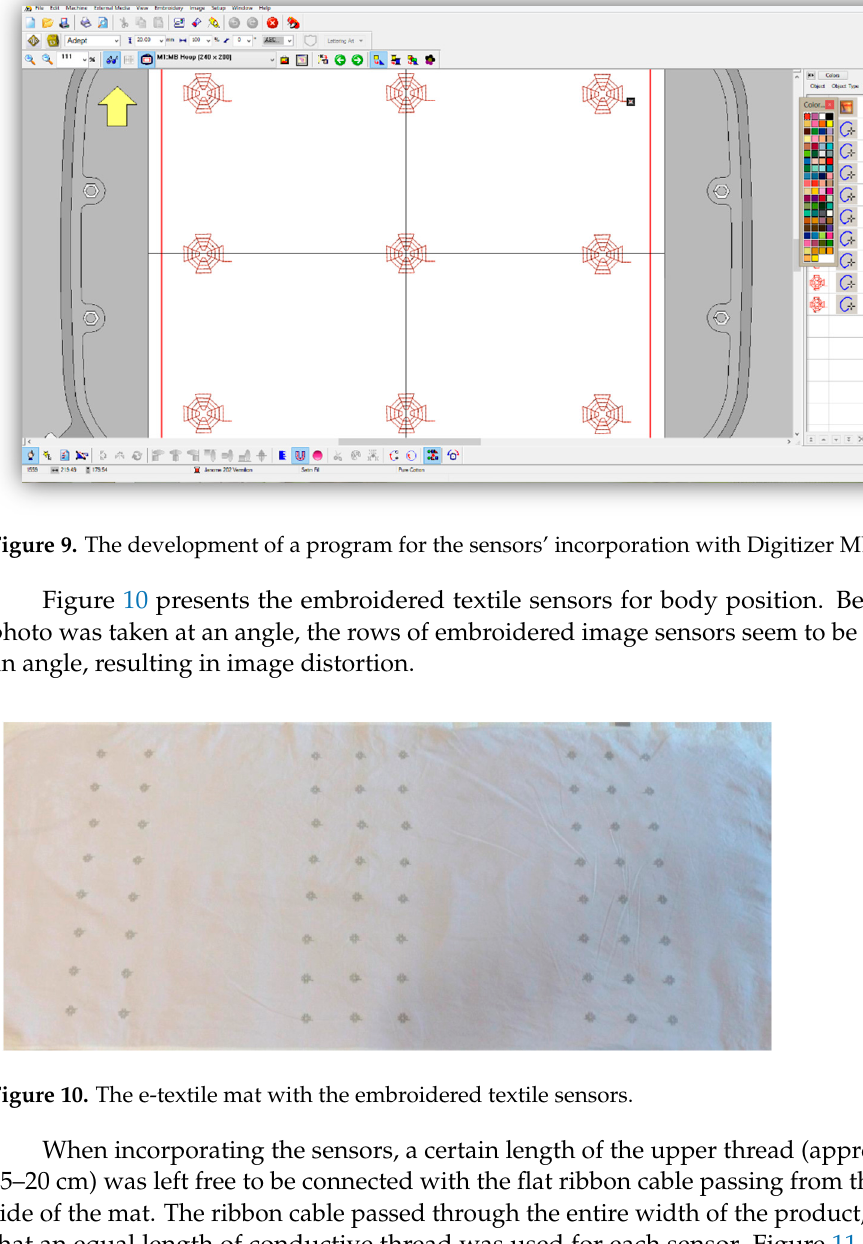
Figure 10. The e ‐ textile mat with the embroidered textile sensors. Figure 10. The e-textile mat with the embroidered textile